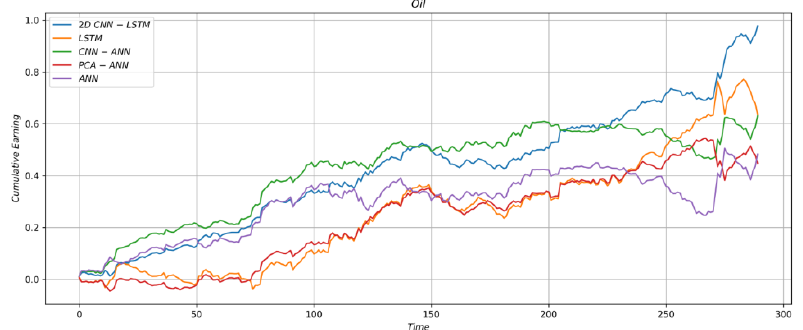
Figure 12. Comparison of Cumulative Trading Profit with One-Day-Ahead.